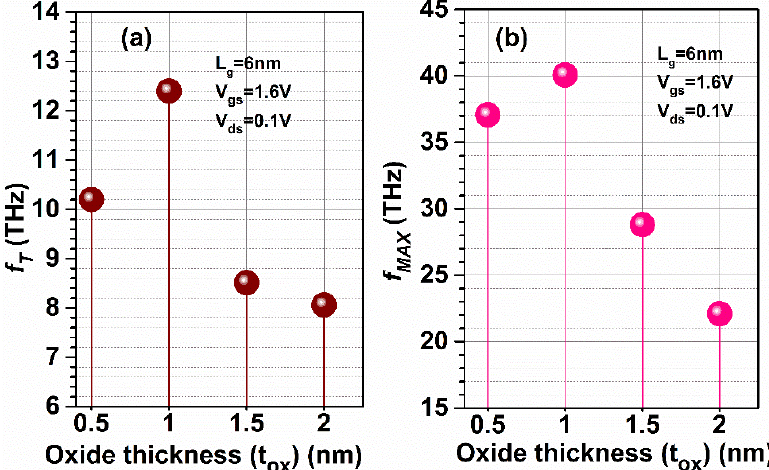
Figure 17. ( a ) f T and ( b ) f MAX at various oxide thicknesses of GaN-SOI-FinFET.